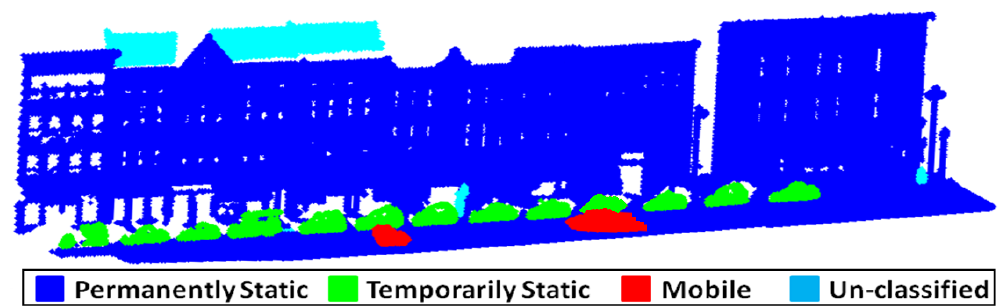
Figure 4. Classification of the objects present in the urban scene into three main classes.